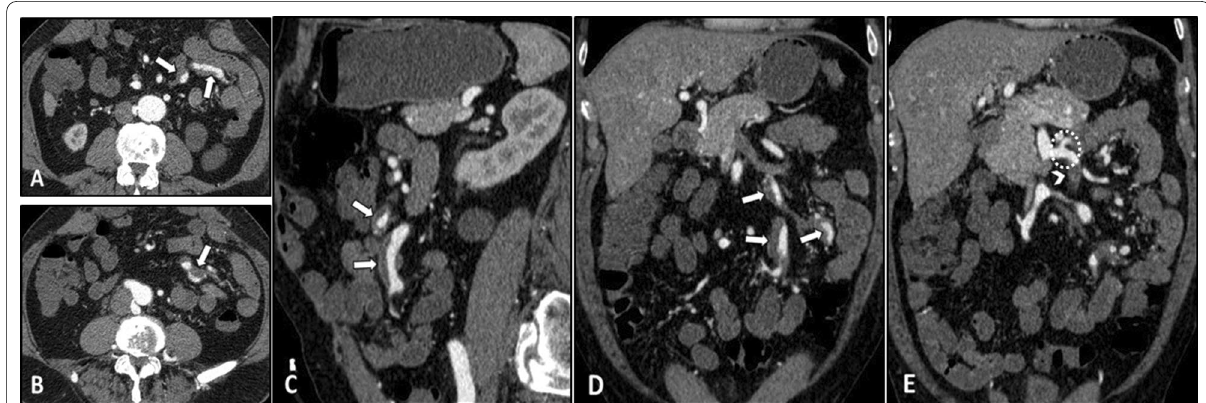
Fig. 22 Segmental arterial mediolysis (SAM) in a 55-year-old male presenting with epigastric pain for ten days and normal laboratory results. Axial, sagittal, and coronal images from CTE ( A – D ) show fusiform aneurysmal dilatation of two jejunal branches of SMA associated with partial mural thrombosis (thick white arrows). Coronal CTE ( E ) demonstrates aneurysmal dilation and high-grade thrombosis at a jejunal branch of SMA (white arrowhead) with sparing of proximal arterial bifurcation (white dotted